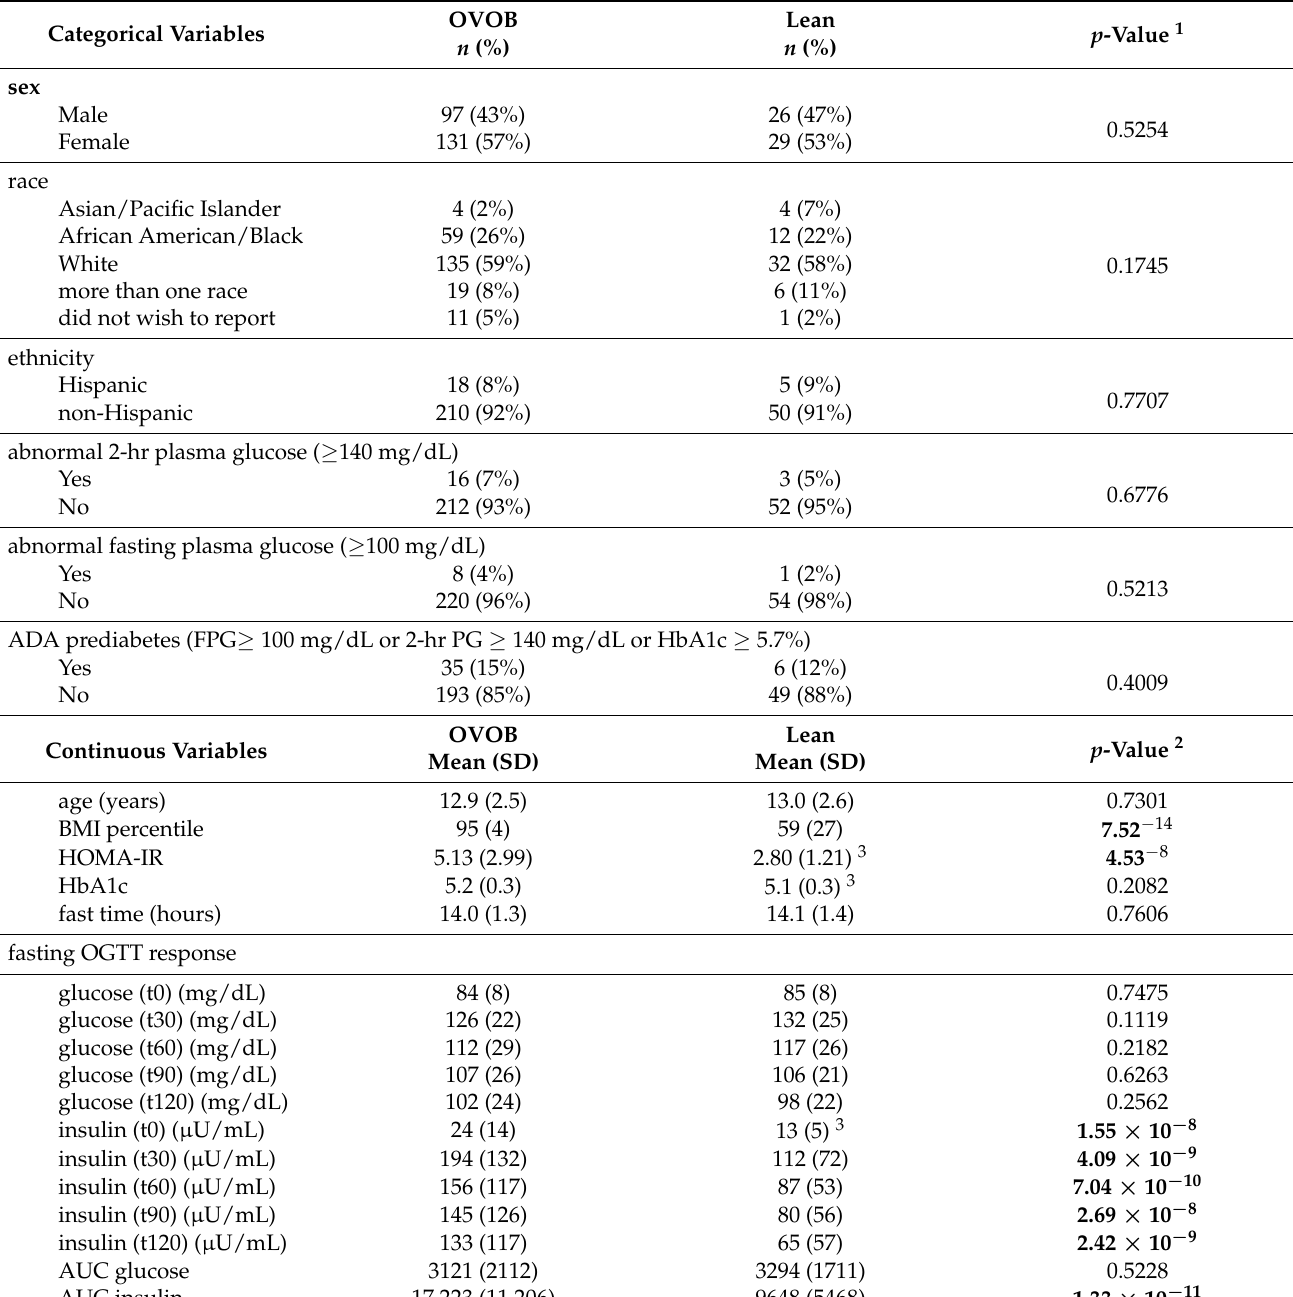
Table 1. Characteristics of study participants at the Fasted Visit, stratified by weight group. Significance denoted with unadjusted p -value < 0.05 (bolded).